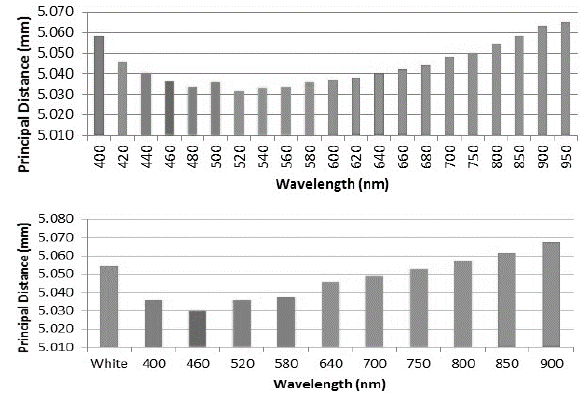
Figure 7. Variation in Principal Distance with Wavelength.